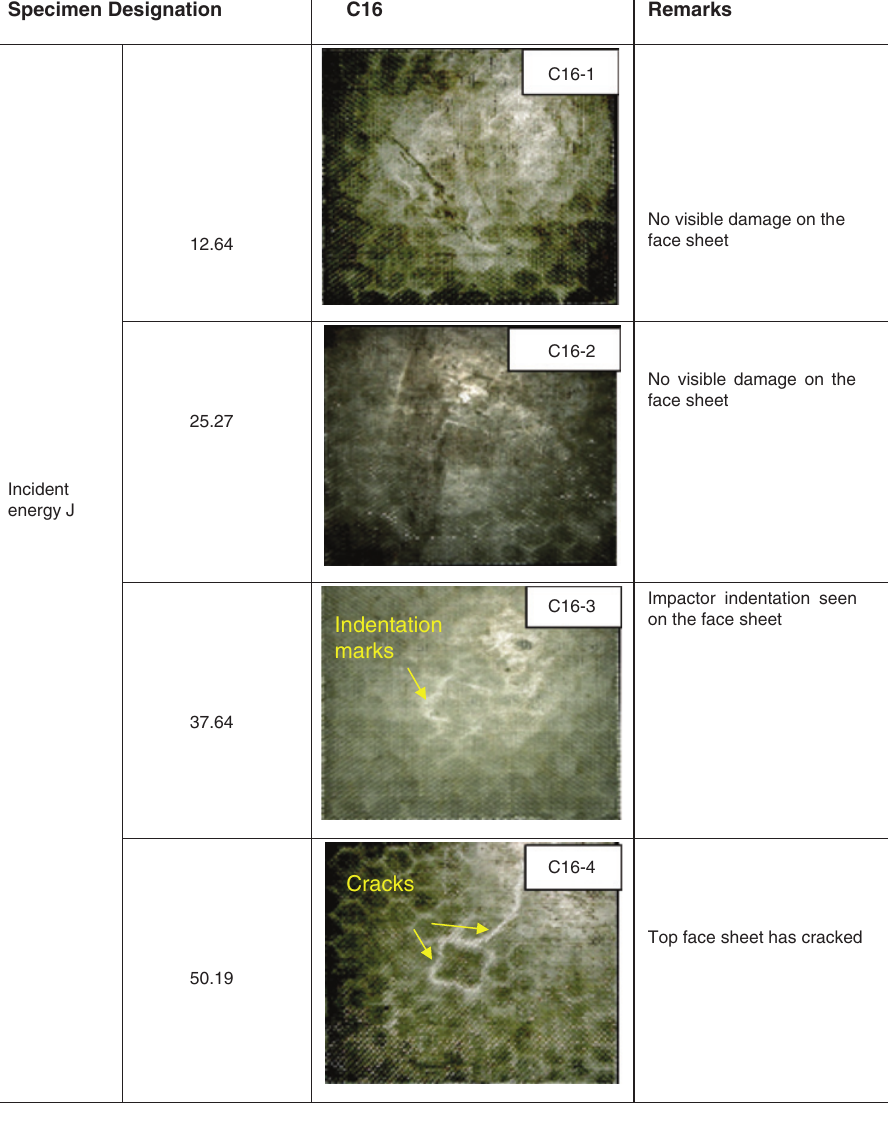
Figure 12 Post-impact images of specimen C16 at various energy